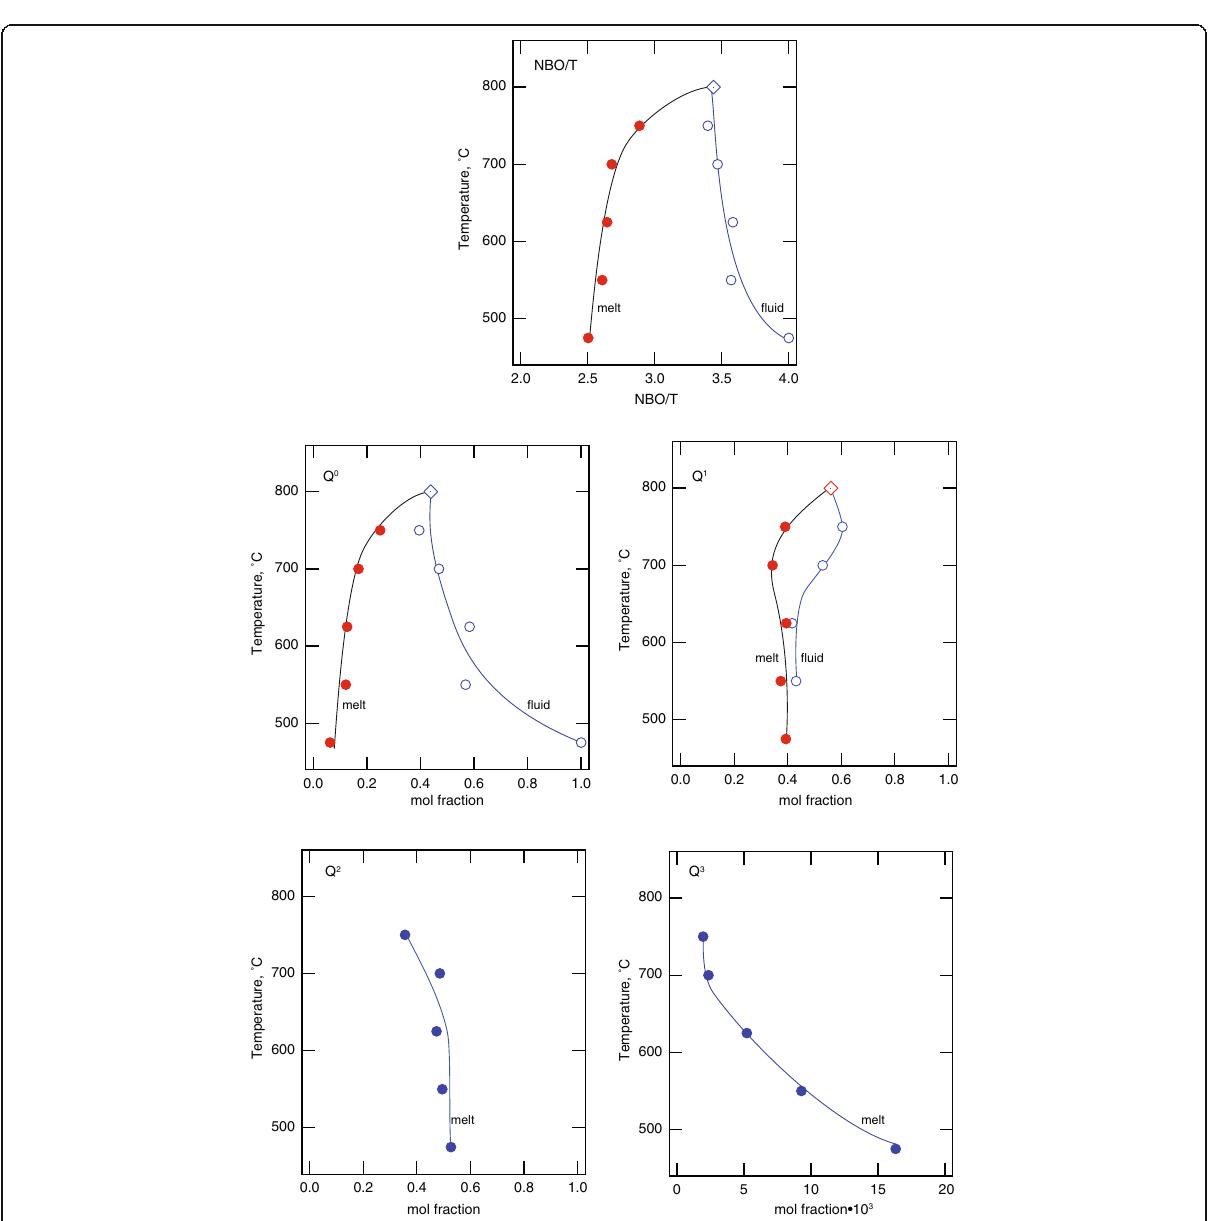
Fig. 11 Evolution of Q-species abundance and bulk NBO/T of melt and coexisting fluid as a function of temperature (and pressure, see Table 1). Note that diamond symbol represents single